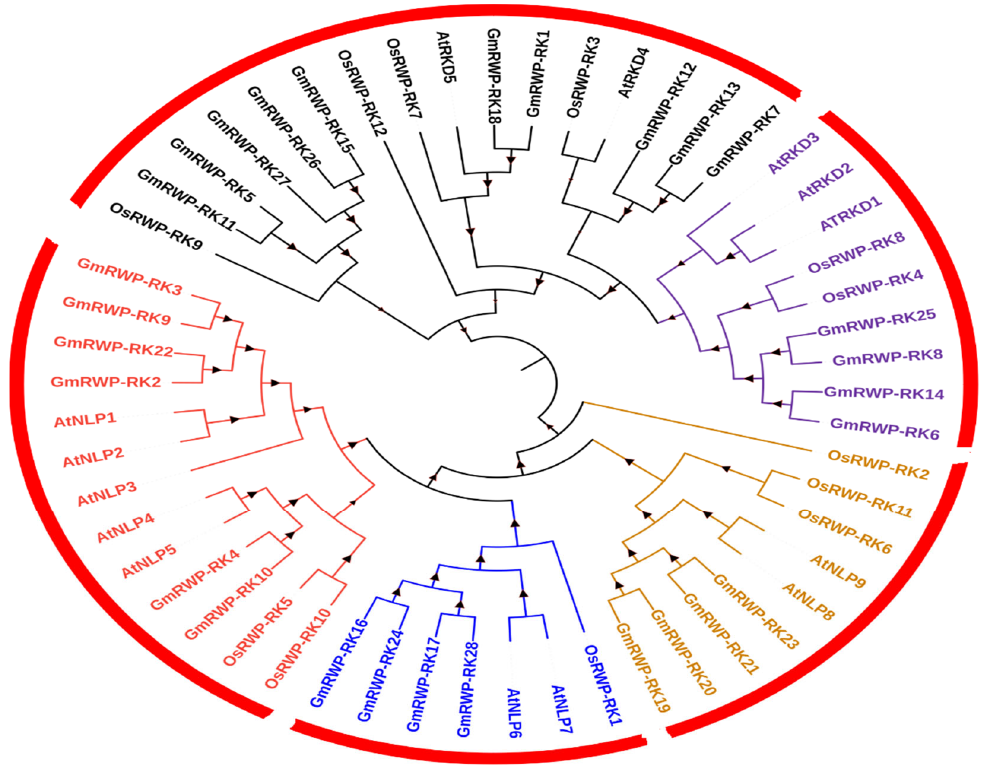
Figure 1. Phylogenetic analysis of RWP ‐ RK proteins from soybean, Arabidopsis, and rice. A total of 28 RWP ‐ RK members from soybean, 14 members from Arabidopsis, and 12 members from rice were included in the phylogenetic tree using the maximum likelihood method in MEGA version (6.0).